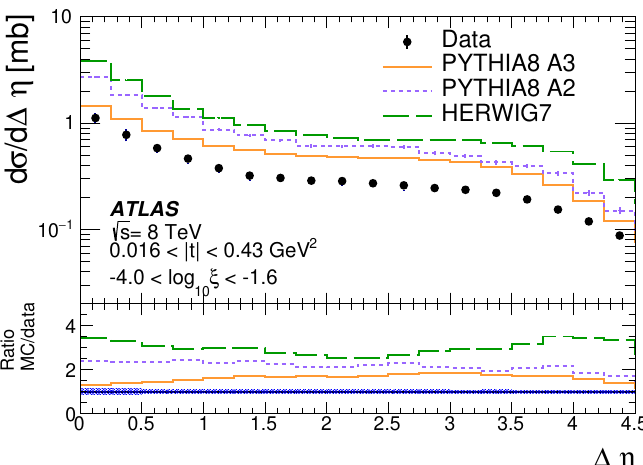
Figure 3. Hadron-level di(cid:11)erential SD cross section as a function of (cid:1) (cid:17) , comparing the measured data with Pythia 8 and Herwig 7 predictions. The error bars on the data points and the band around unity in the MC/data ratio show the combination in quadrature of fractional statistical and systematic